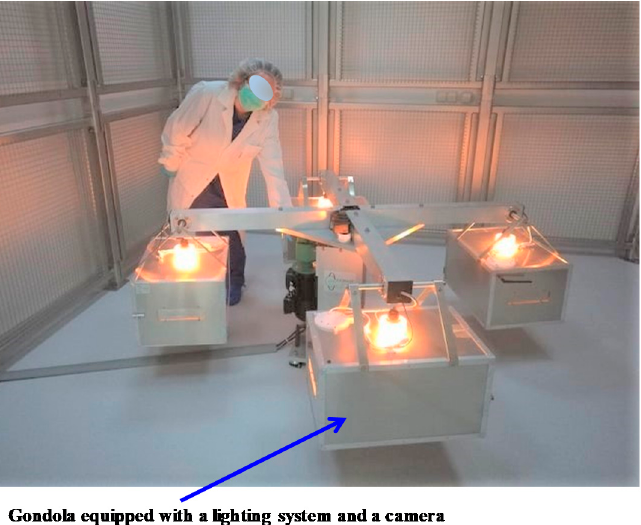
Figure 7. Large-radius rodent rotor allowing the exposure of mice to any desired g-level up to a maximum of 4 g.